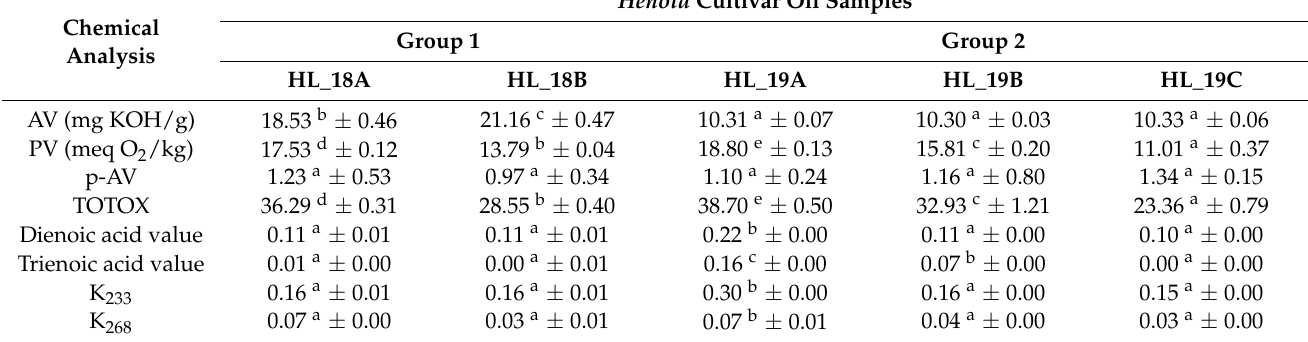
Table 4. Acid values, peroxide values, p-anisidine values, TOTOX values, dienoic and trienoic acid values, and specific extinctions coefficient at UV wavelengths 233 and 268 for cold-pressed hemp seed